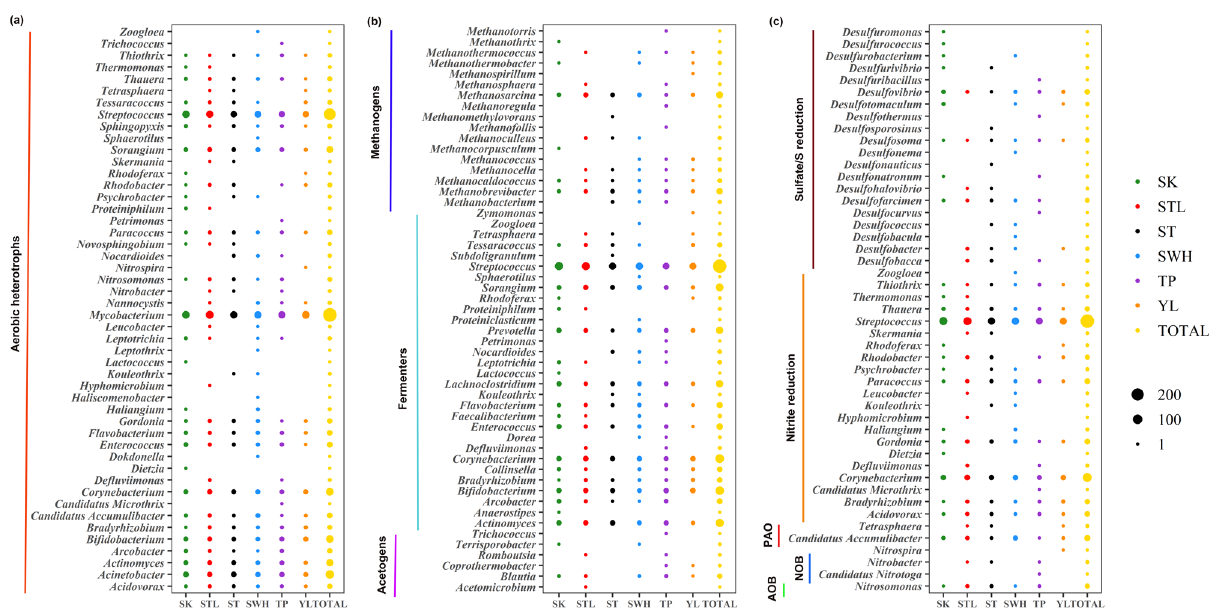
Fig. 4 Virus – host pro fi les of functional microorganisms in WWTPs. a Virus – host pro fi les of functional microorganisms related to aerobic oxidation. b Virus – host pro fi les of functional microorganisms related to the anaerobic process. c Virus – host pro fi les of functional microorganisms related to nutrient removal (N, P, S). The size of the circle indicates the number of viral genera that could infect the corresponding microbial genera. Source data are provided as a Source Data fi